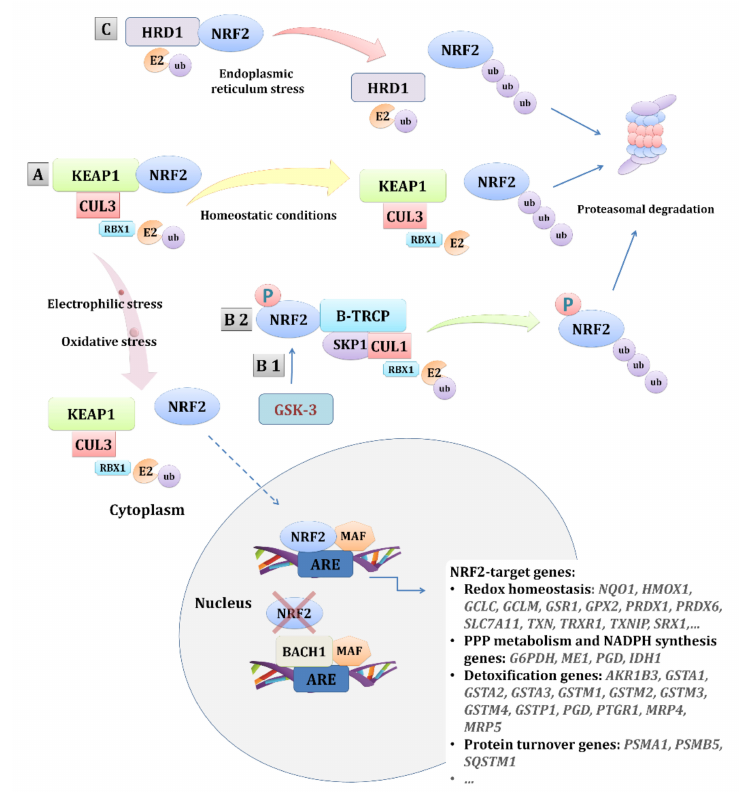
Figure 1. Regulation of the NRF2 pathway. NRF2 is regulated by three E3 ubiquitin ligases. The main regulation is by the complex KEAP1-CUL3-RBX1 ( A ). Additionally, NRF2 can be regulated by the β -TRCP-SKP1-CUL1-RBX1 complex in a GSK-3-dependant ( B 1) or -independent ( B 2) manner. Upon endoplasmic reticulum stress, NRF2 can also be regulated by HRD1 ( C ). The main regulation ( A ) involves the repression of NRF2 by KEAP1 and its proteasomal degradation in basal conditions, while, under oxidative stress conditions, the NRF2-KEAP1 binding is disrupted, leading to NRF2 nuclear translocation and the activation of its target genes. Other mechanisms of NRF2 repression involve the β -TRCP-SKP1-CUL1-RBX1 complex ( B 1 / 2) that, through binding with the Neh6 domain of NRF2, particularly enhanced by the GSK-3 phosphorylation of NRF2, or, by the binding of endoplasmic reticulum stress-induced HRD1 ( C ) with the Neh4-5 domains of NRF2, mediate its degradation. In addition, other proteins, such as BACH1, can negatively regulate the transcriptional activation of the NRF2-target genes by competing with NRF2. Abbreviations: AKR1B3—aldo-keto reductase family 1 member